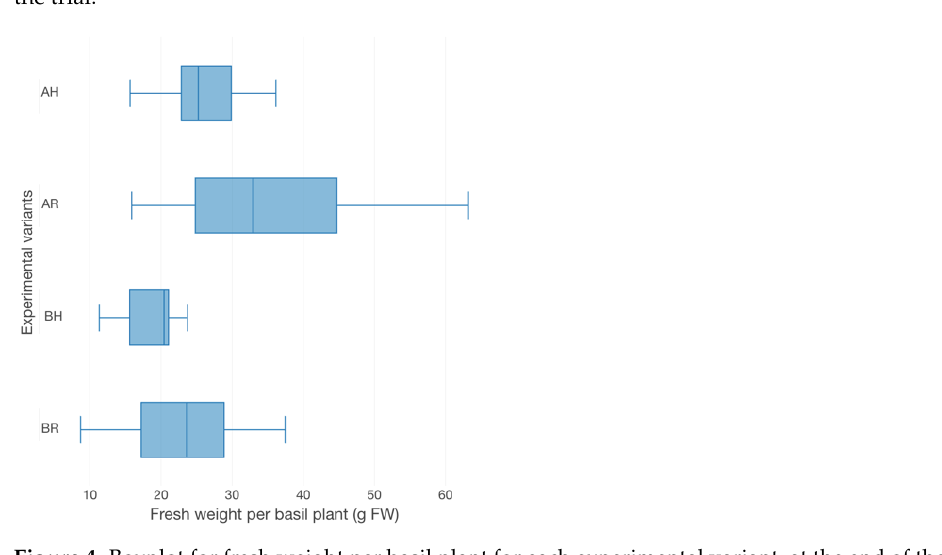
Figure 3. Boxplot for basil height and number of leaves for each experimental variant, at the end of the trial.